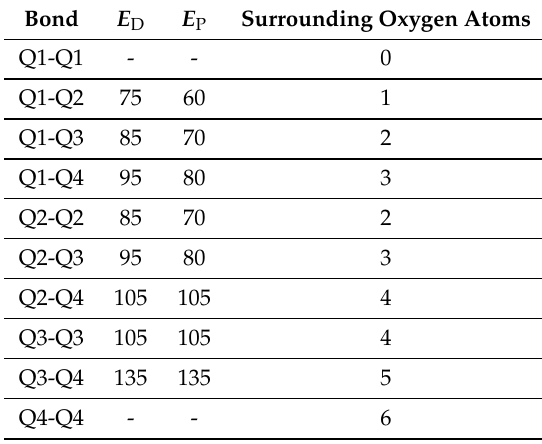
Table 3. Model energy barrier values with the bond surroundings in kJ mol − 1